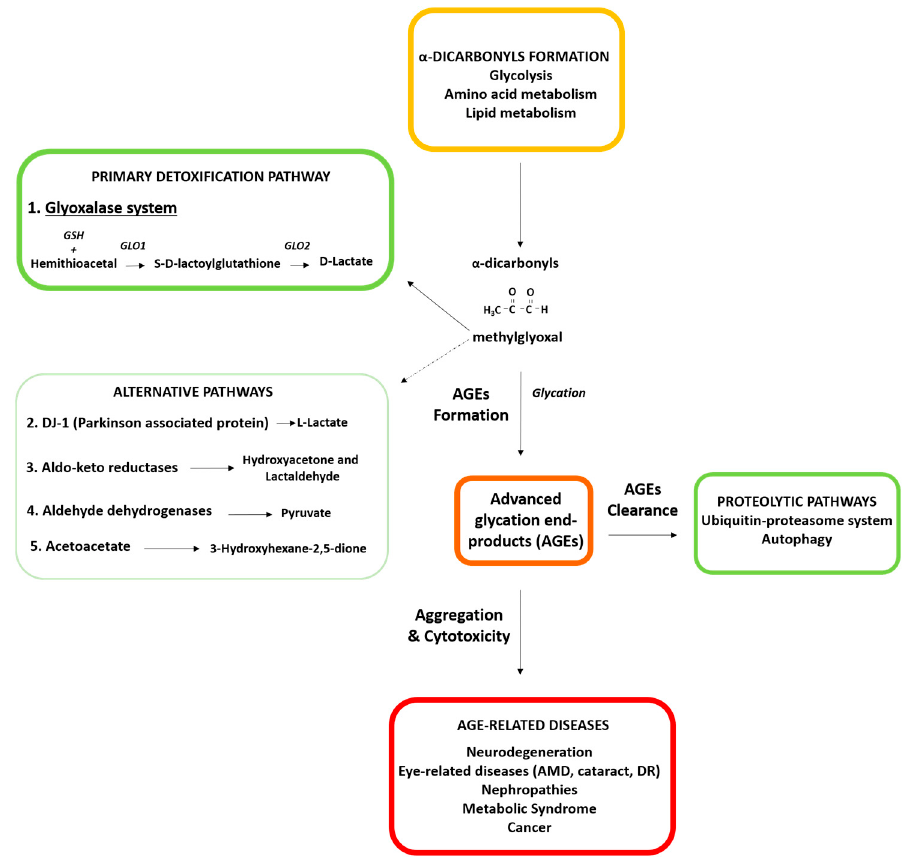
Figure 1. Schematic diagram of α -dicarbonyls formation and detoxification pathways against AGE-derived damage in aging. The formation of highly reactive α -dicarbonyls such as methylglyoxal (MG) is through non-enzymatic degradation of the glycolytic intermediates, including dihydroxyacetone phosphate and glyceraldehyde 3-phosphate and other sources, including aminoacid and lipid metabolism. In order to avoid AGE damage, the glyoxalase system is a primary mechanism that limits the synthesis of AGEs, converting high reactive biomolecules, such as MG, into less reactive biomolecules (D-lactate). This process involves the sequential activity of two enzymes GLO1 and GLO2 and the reduced form of gluthatione (GSH). Other detoxifying mechanisms imply the activity of DJ-1, aldehyde dehydrogenases (ALDHs), aldo-keto reductases (AKRs), and acetoacetate degradation enzymes. Once formed, AGEs can be cleared by two proteolytic pathways: the ubiquitin-proteasome (UPS) system and autophagy. These protective mechanisms (highlighted in green) decline under aging and contribute to the onset of age-related diseases such as neurodegeneration, eye-related diseases (AMD, cataract, DR), nephropathies, metabolic syndrome, and cancer. GLO1: glyoxalase 1; GLO2: glyoxalase 2; GSH: